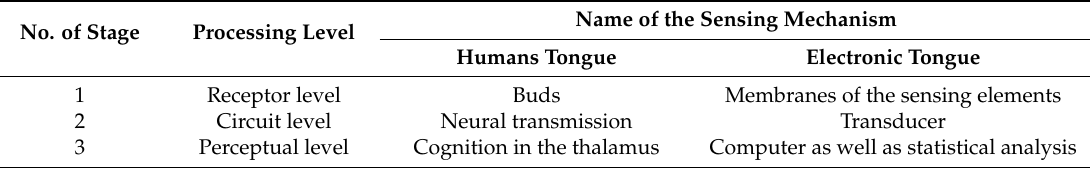
Table 2. Three levels of analogy between human and electronic tongue taste recognition